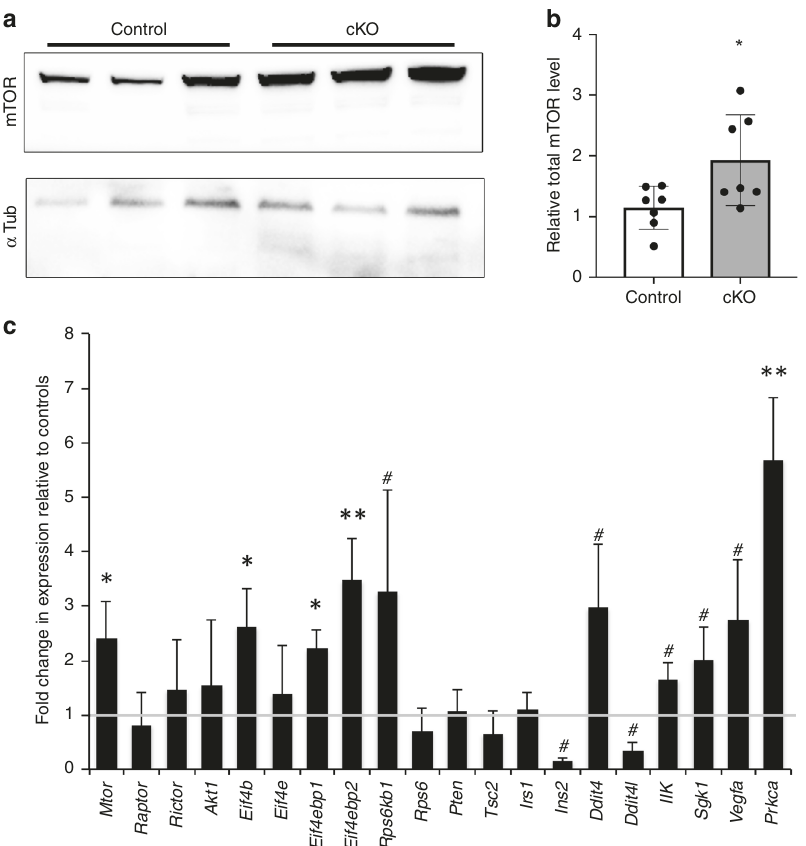
Fig. 4 mTOR levels are elevated in Fbxw7 mutants. Western blot analyses of sciatic nerve lysates indicate a 2-fold increase in mTOR protein in Dhh cre ( + ) : Fbxw7 fl / fl (cKO [conditional knockout]) nerves compared with littermate controls when normalized to both background and alpha-tubulin levels ( a , b ; p = 0.0350, unpaired t -test with Welch ’ s correction). mTOR mRNA is also upregulated in Dhh cre ( + ) :Fbxw7 fl / fl nerves ( c ; mTOR p = 0.0236, Eif4b p = 0.417, Eif4ebp1 p = 0.0398, Eif4ebp2 p = 0.0087, Prkca p = 0.0073; # = p < 0.1; one-way ANOVA), as are multiple mTOR targets. The gray line at y = 1 denotes control levels. For western blots: N = 5 controls, N = 5 Dhh cre ( + ) :Fbxw7 fl / fl at P42. For qPCR, N = 3 control and 3 Dhh cre ( + ) :Fbxw7 fl / fl at P21. Error bars depict